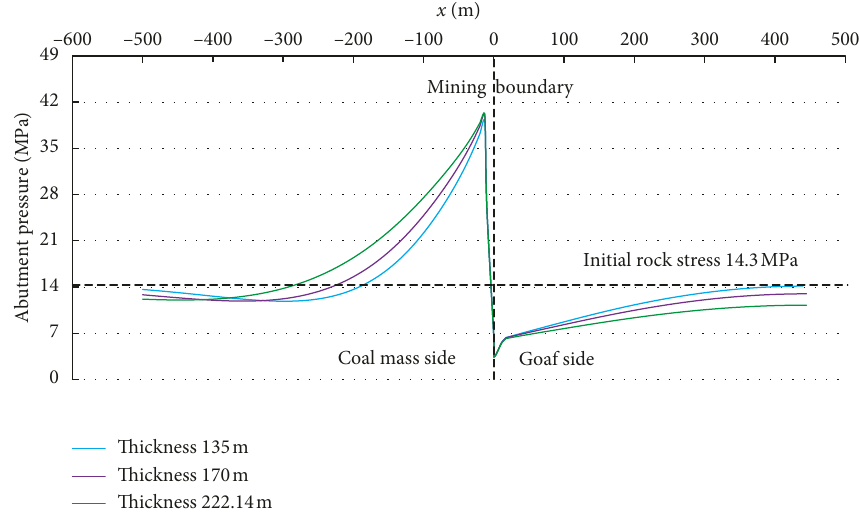
Figure 14: Abutment pressure distributions under different KS